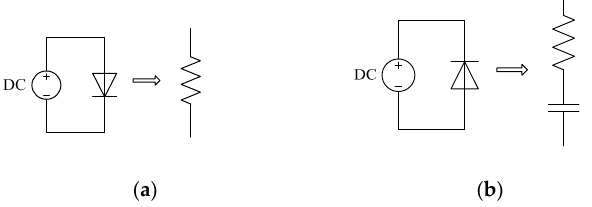
Figure 5. ( a ) Forward bias model of PIN diode and ( b ) Reverse bias model of PIN diode.